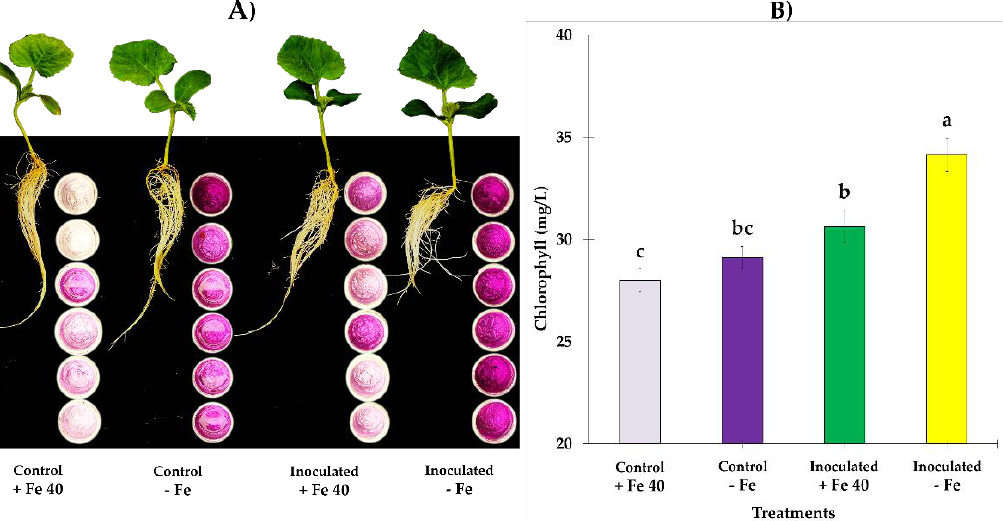
Figure 7. ( A ) General panorama of FRA on roots of C. melo at 5 dpi . On the right side of the roots, the indicator solution containers can be seen at 5 dpi with clearly significant difference between controls and inoculated plants. Also, abundant secondary roots growth can be observed; in shoots of inoculated plants did not show chlorosis symptoms. ( B ) Mean of SPAD values at 7 dpi revealed significant difference with inoculated plants exceed their respective controls, being the plants grown in Fe deficient conditions those that reached higher values in chlorophyl content. Letter over the bars denote significant difference between plants inoculated and control plants analyzed by completely randomized ANOVA followed by a Tukey test ( p < 0.05).